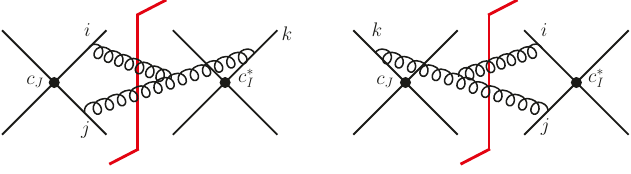
Figure 4 . A pair of three-Wilson-line double-real diagrams adding up to